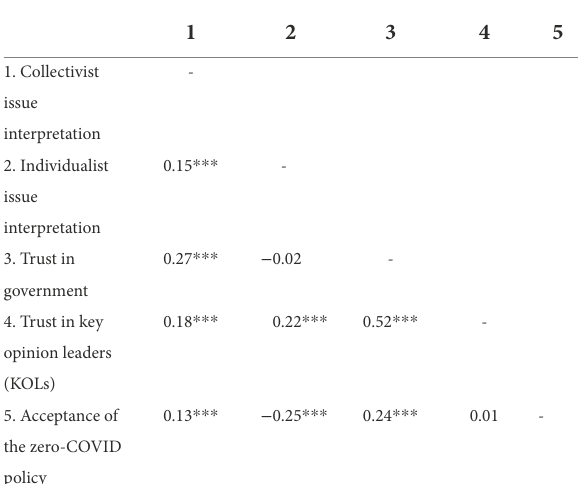
TABLE 2 Correlation among study